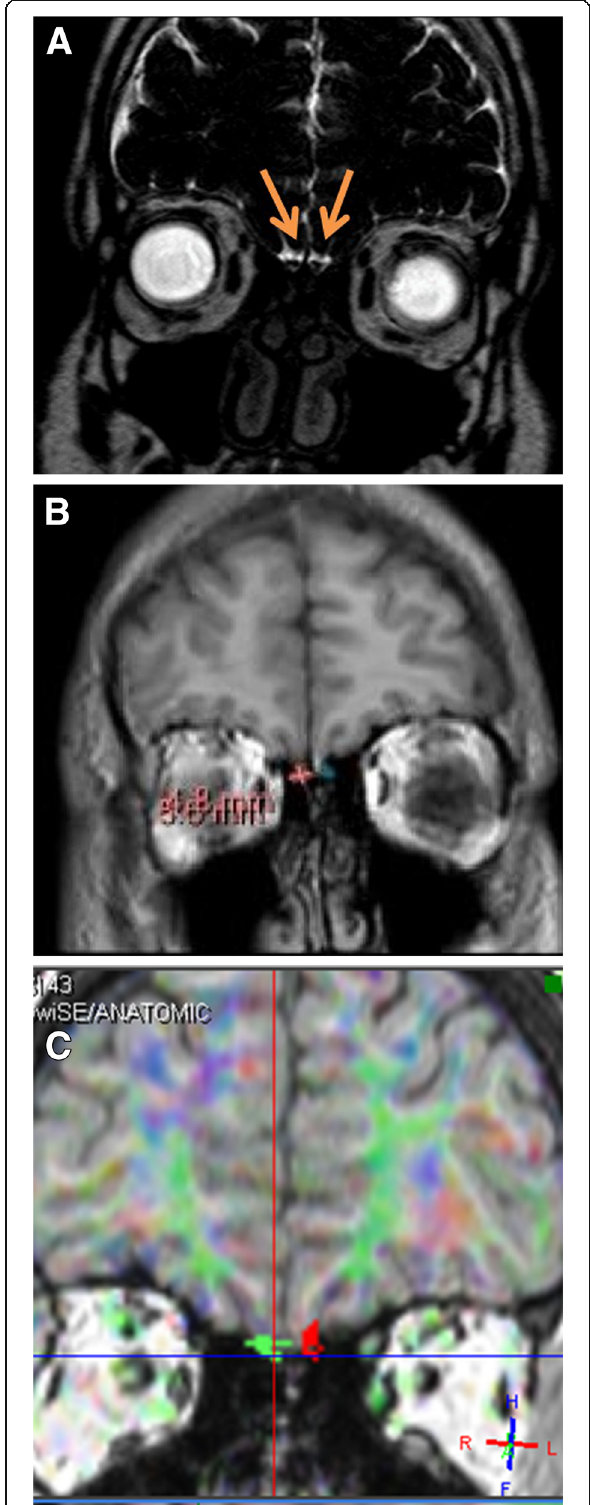
Fig. 3 OB/T in a normal volunteer. Arrows in 3D DRIVE ( a ), 3D T1WI volumetry ( b ), and MR tractography ( c